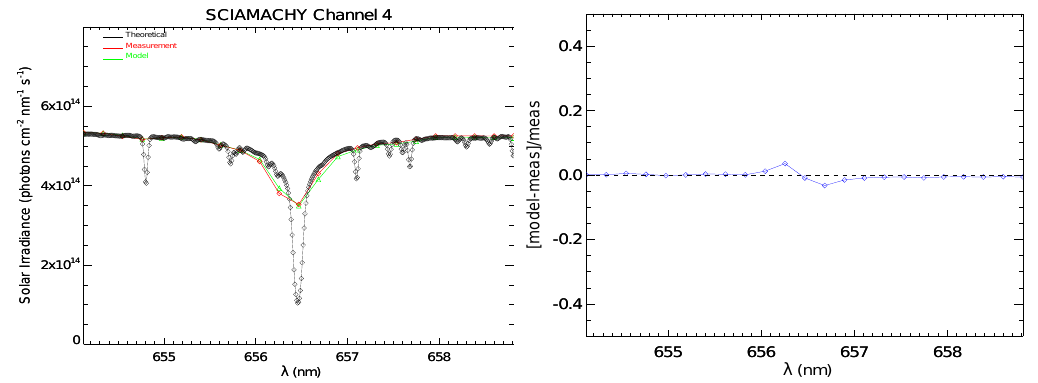
Figure 6. Similar to Figure 3 but for Channel 4 and Line 1. The corresponding retrieved ISRF is a Hyperbolic function with a FWHM (cid:39) 0.43 nm. The residuals ( right ) rms (cid:39) 0.012. This particular line revealed an exceptional shift of the ISRF compared to other